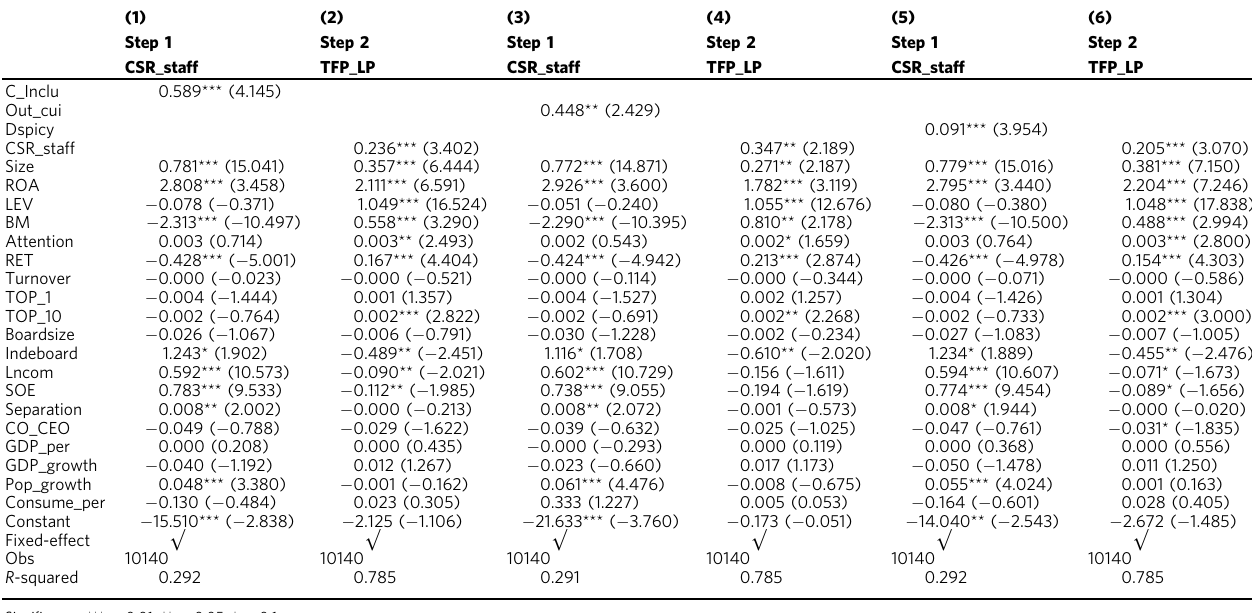
Table 9 The impact of cultural inclusion on corporate sustainability: